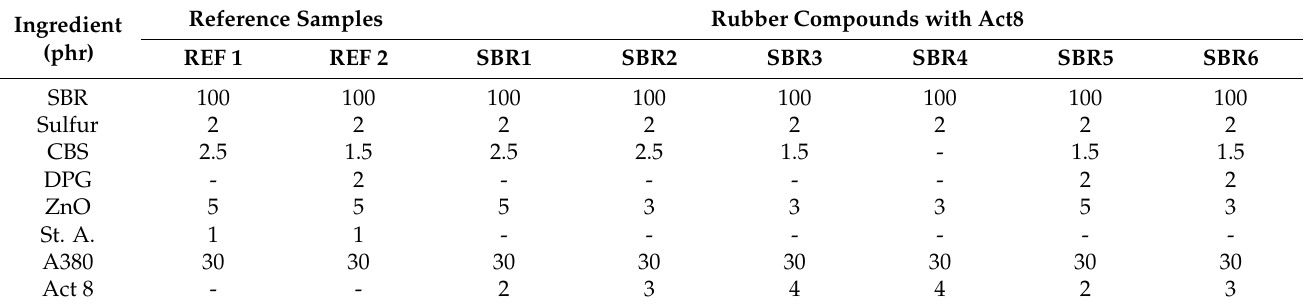
Table 1. Recipes of the SBR rubber compounds, parts per hundred of rubber